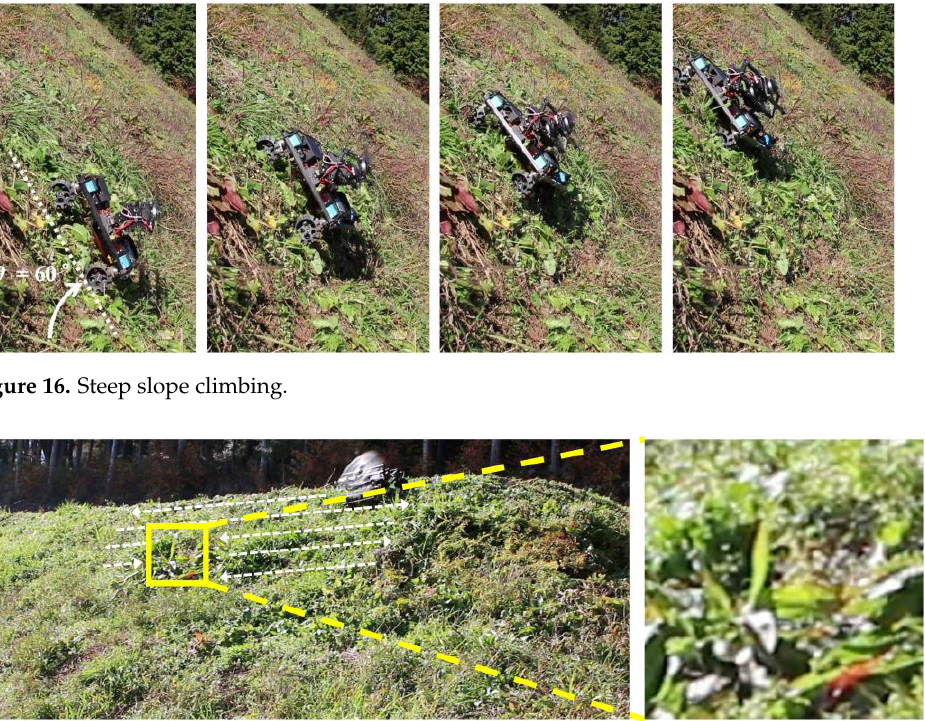
( b ) Figure 17. Grass cutting at different sites (slope angle 41 – 55°). ( a ) Before cutting the grass. ( b ) After cutting the grass.